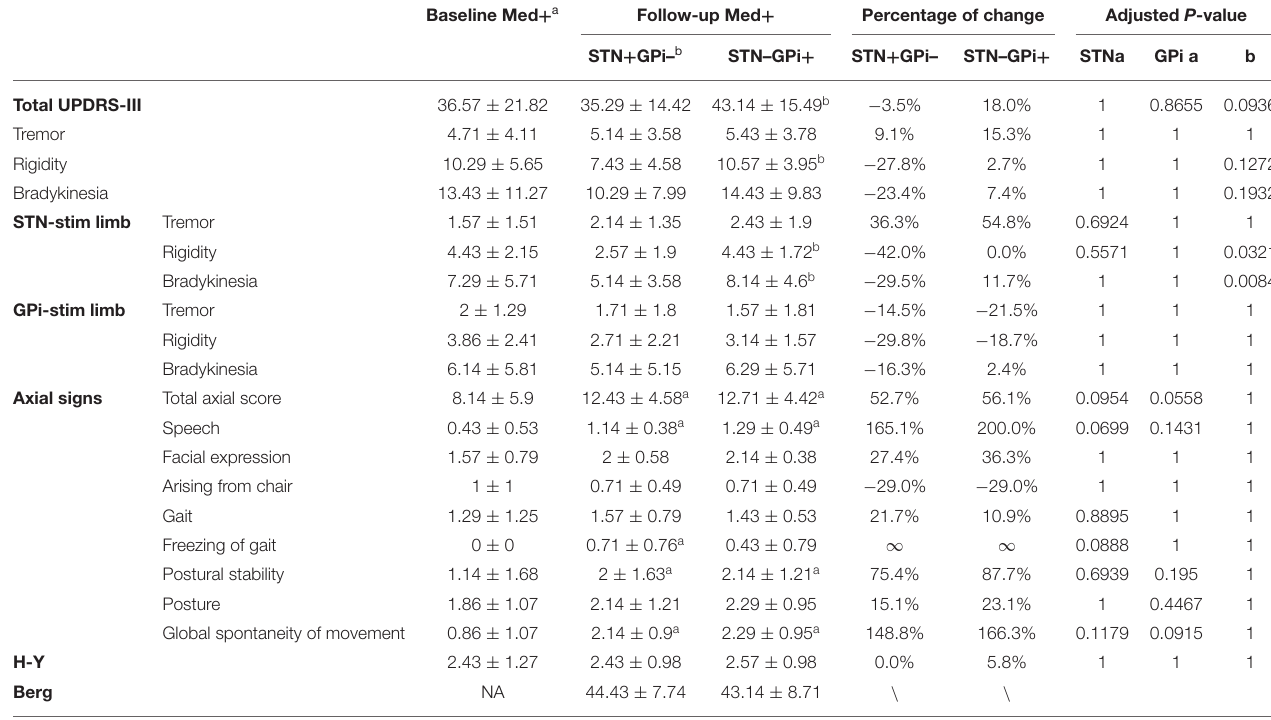
TABLE 3 | Motor symptoms in Med + STN + GPi– and Med + STN–GPi + conditions before and 2 to 3 years after surgery ( n =